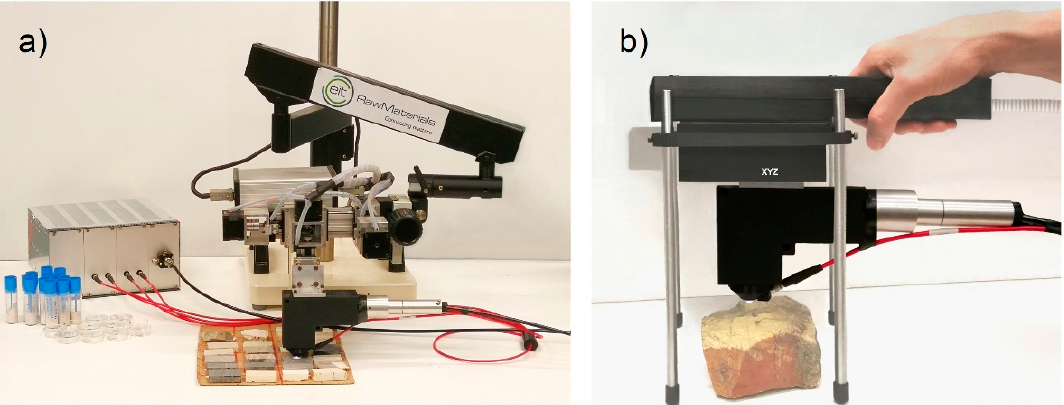
Figure 6. LIBS setups: ( a ) with the endpiece on a XYZ translation group placed on an articulated arm, ( b ) with the endpiece on a handheld XYZ translation group.